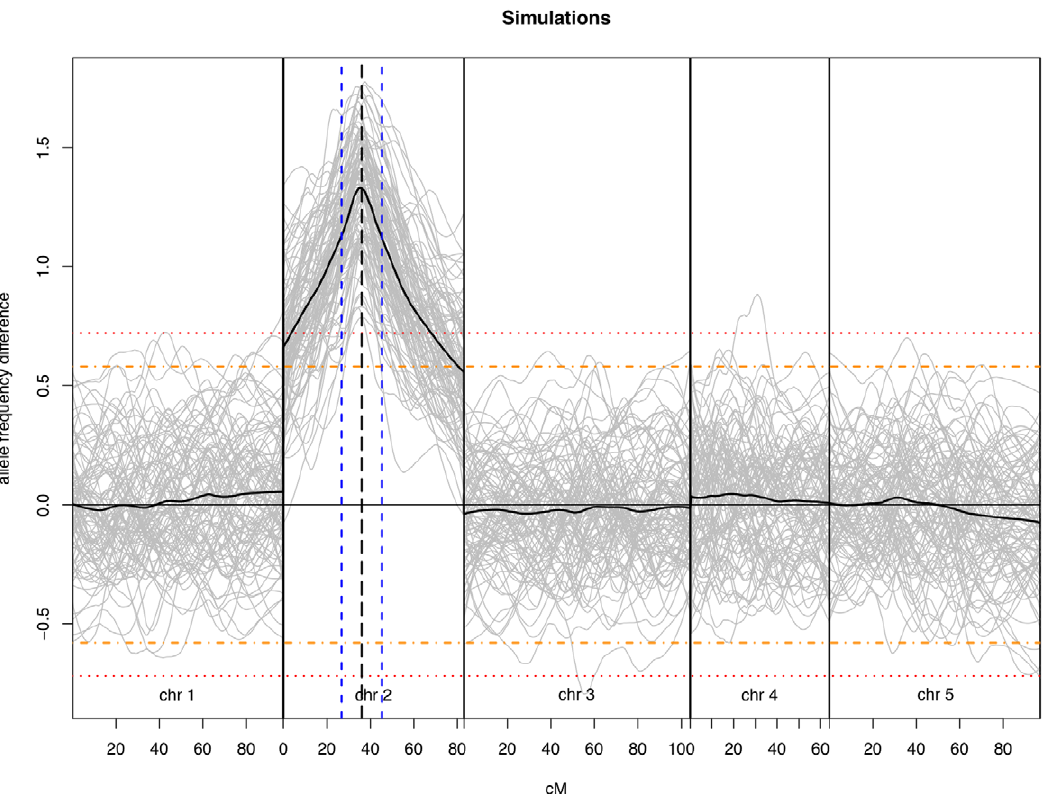
Figure 2. BSA using SNPs simulations. 100 simulations performed by selecting the extreme 10% of phenotypic variation for a population of 200 F 2 plants with a major additive QTL at the 36 th centimorgan on the second chromosome, shown in gray. The bold lines represent the average of the 100 simulations for each chromosome. The dashed horizontal orange and red lines represent the 95 and 99% confidence thresholds for detection, respectively, established by the 1000 permutation simulations displayed in Table1. The black dashed vertical line represents the location of the simulated QTL, with the neighboring blue dashed lines representing the boundaries of the 18.5 cM wide confidence interval formulated from our simulations.